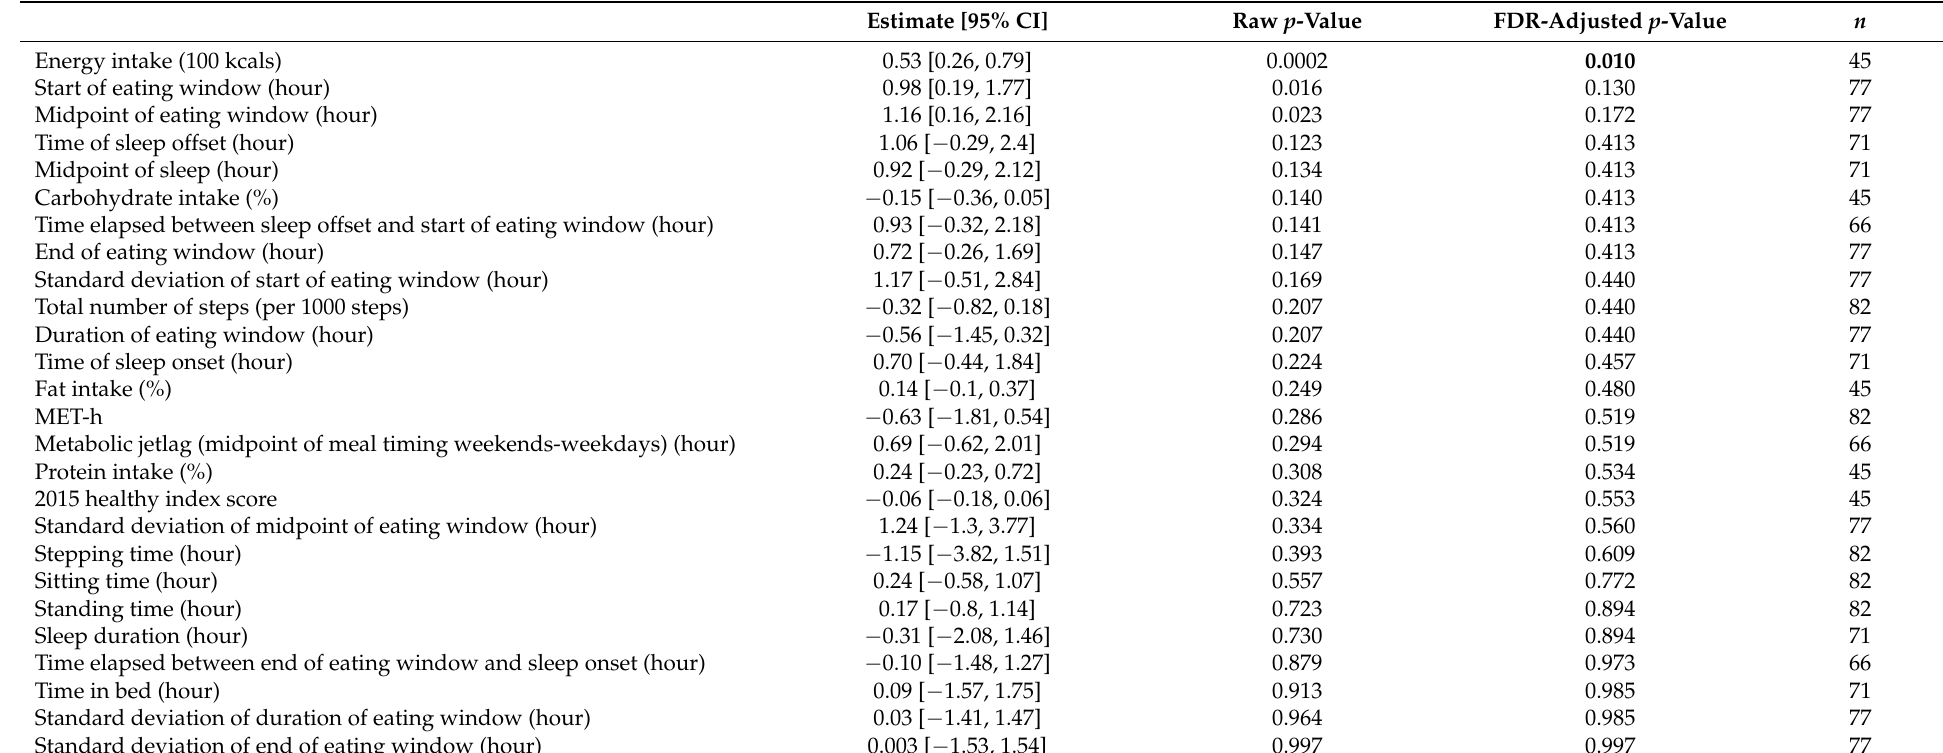
Table 4. Linear regressions with body mass index